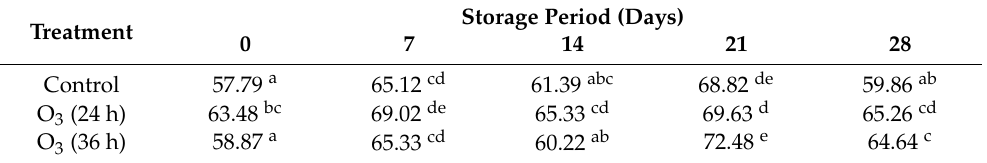
Table 5. Effect of gaseous ozone (0.25 mg/L) on chroma of mango fruit inoculated with L. theobromae , stored at 10 ◦ C for three weeks and ripened at ambient temperature for one